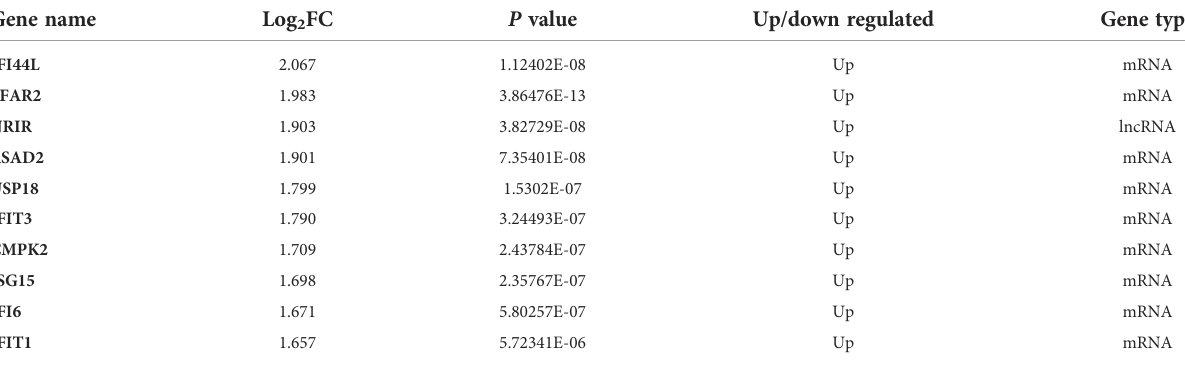
TABLE 2 The Top 10 ISGs that were signi fi cantly and differentially expressed in PBMCs of SLE patients and healthy